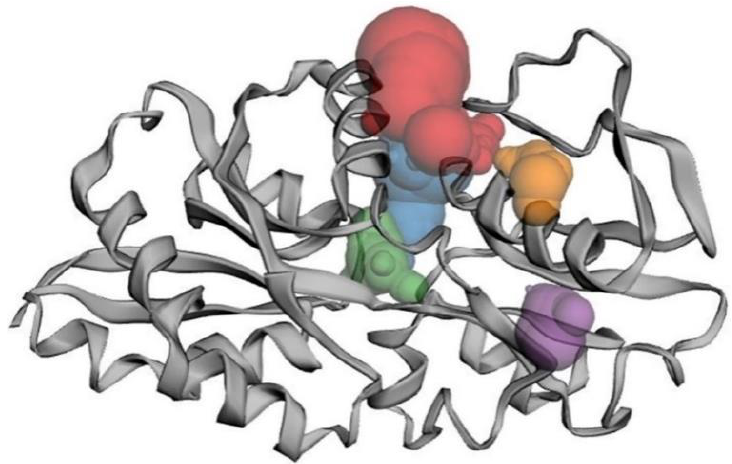
Figure 6. Binding cavity of Lpp. Hydrophobic residues present in the major and minor cavities of the protein model were visualized. The top 5 binding sites (red, blue, green, purple, orange) were observed using the CASTp server. The first red color-marked cavity shows the larger area and volume in the Lpp protein. Both area and volume shown are solvent-accessible surface area/volume (Lee-Richard molecular surface).